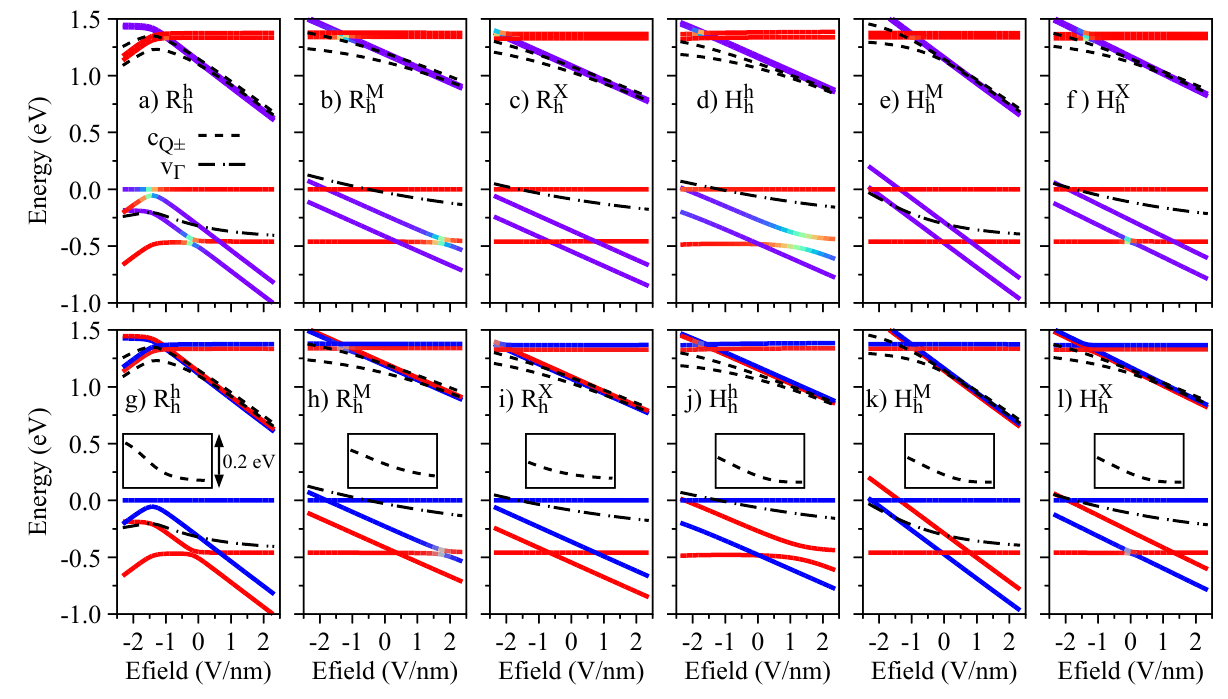
Figure 3. Energy dependence with respect to the electric field of the relevant low-energy bands (see Figure 1g) for all considered stackings: the top row, panels ( a – f ), indicates the color-coded layer decomposition of the K point bands (same color code as in Figures 1a–f); the bottom row, panels ( g – l ), indicates the color-coded spin decomposition of the K point bands (same color code as in Figures 2a–f); the insets in panels ( g – l ) show the energy difference between c Q + and c Q − bands, emphasizing an anti-crossing at larger electric fields.